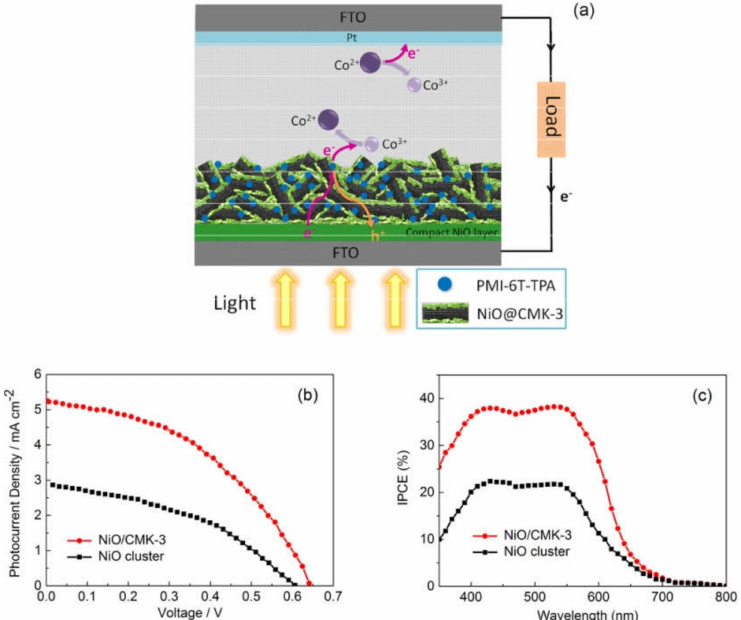
Figure 5. ( a ) p -DSSC structure and scheme for the electron-transfer processes occurring in the p -DSSC; ( b ) Current–density–voltage characteristics of p -DSSCs; ( c ) IPCE spectra of p -DSSCs sensitized by